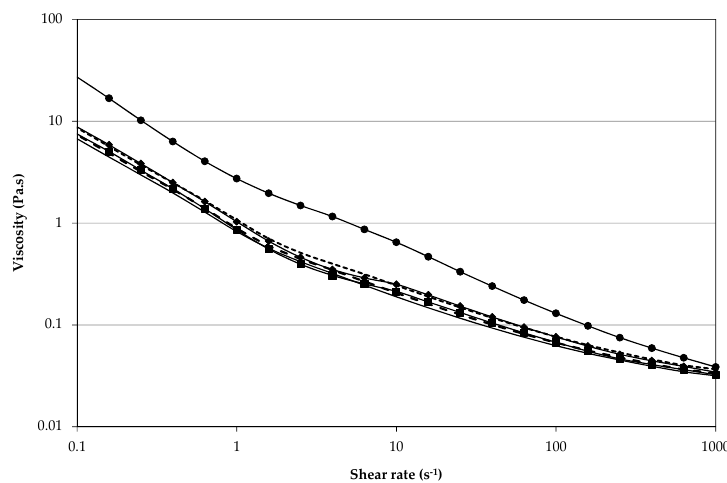
Figure 6. Shear stability was evaluated by applying a shear rate increase to 1000 s − 1 and decrease to 0 s − 1 , the protocol was repeated a total of three times. Black symbols indicate shear increase steps (1st , 2nd , and 3rd ) and straight lines represent shear decrease steps (1st , 2nd , and 3rd ).